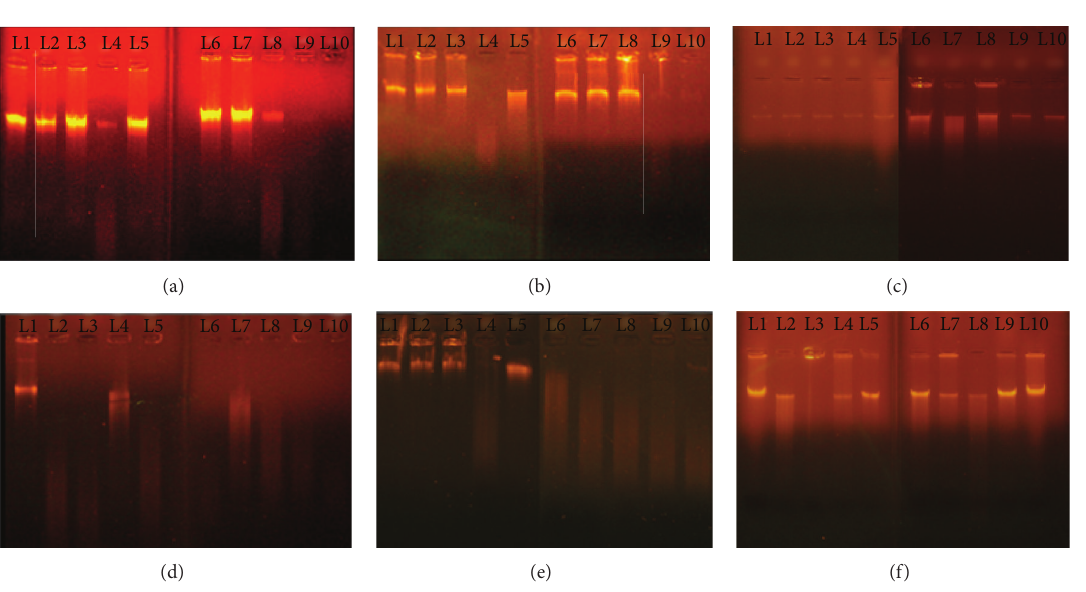
Figure 1: Agarose gel electrophoresis (1.2%) of genomic DNA from nondiabetic human ((a), (b), (c)) and diabetic subject ((d), (e), (f)). L1: Genomic DNA (untreated, control, 15 𝜇 g). L2: DNA (15 𝜇 g) + H 2 O 2 (4mM). L3: DNA (15 𝜇 g) + CuSO 4 (4 mM). L4: DNA (15 𝜇 g) + H 2 O 2 (4mM) + CuSO 4 (4 mM). L5: DNA (15 𝜇 g) + H 2 O 2 (50 𝜇 M) + ∗ Phytocompound (50 𝜇 M) + CuSO 4 (50 𝜇 M). L6: DNA (15 𝜇 g) + H 2 O 2 (500 𝜇 M) + ∗ Phytocompound (500 𝜇 M) + CuSO 4 (500 𝜇 M). L7: DNA (15 𝜇 g) + H 2 O 2 (1mM) + ∗ Phytocompound (1mM) + CuSO 4 (1mM). L8: DNA (15 𝜇 g) + H 2 O 2 (2mM) + ∗ Phytocompound (2mM) + CuSO 4 (2 mM). L9: DNA (15 𝜇 g) + H 2 O 2 (4mM) + ∗ Phytocompound (4 mM) + CuSO 4 (4mM). L10: DNA (15 𝜇 g) + H 2 O 2 (6 mM) + ∗ Phytocompound (6 mM) + CuSO 4 (6mM). ∗ Caffeine, curcumin, and